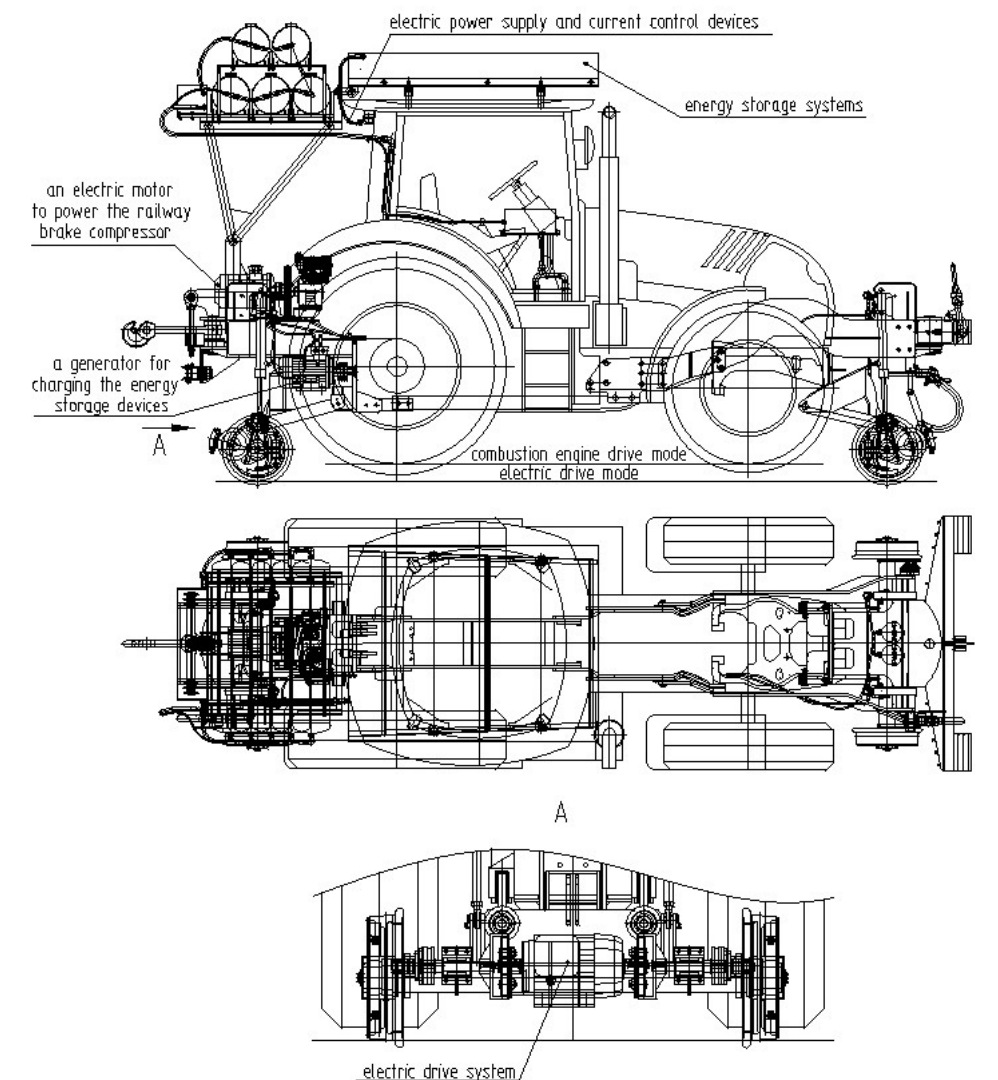
Fig. 2. Schematics of the rail-road tractor with a diesel-electric